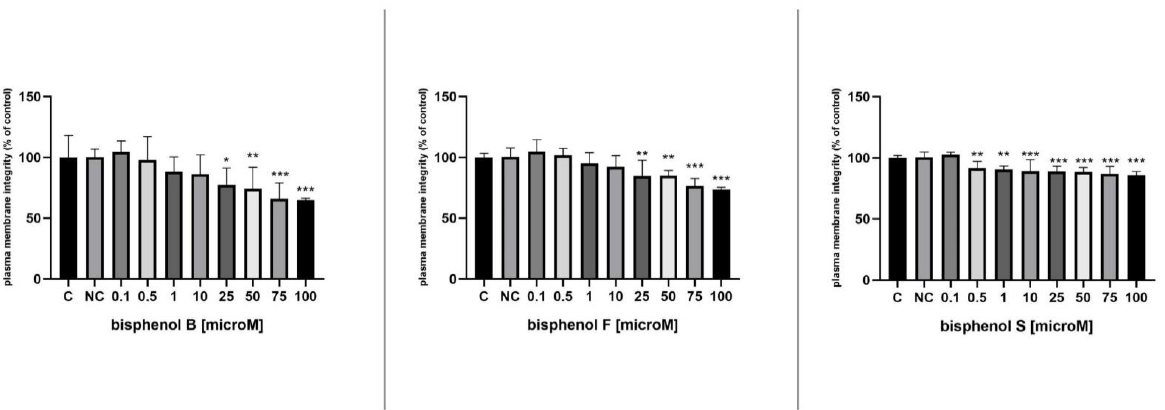
Figure 3. The impact of bisphenol B, F, and S on H295R cells membrane integrity in vitro. Abbreviations: C—control group, NC—negative control. The mean ( ± SEM) optical density percent of the control (untreated) and treated (bisphenol) groups is represented by each bar. The data were collected from three separate experiments. Between the control and experimental groups, the significance levels were established at *** ( p < 0.001), ** ( p < 0.01), and * ( p < 0.05).